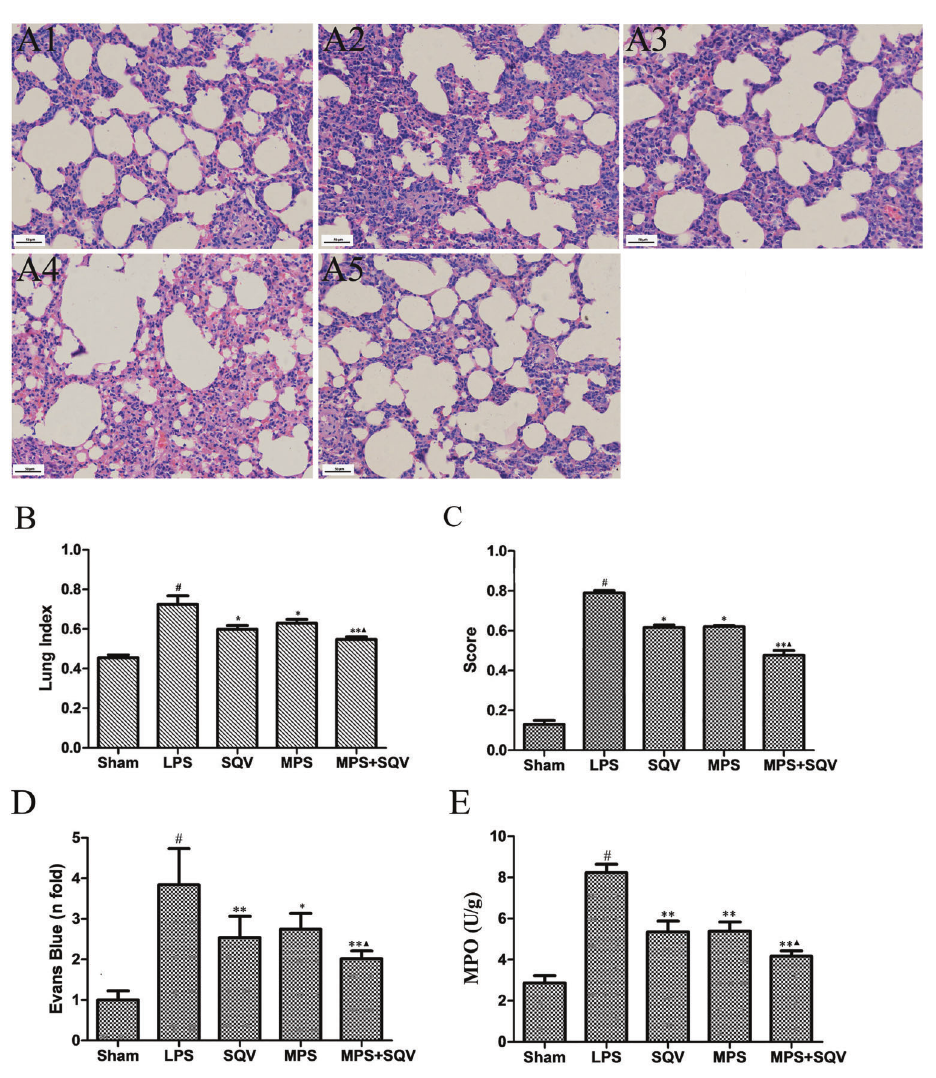
Figure 5. In fl uence of saquinavir (SQV) plus methylprednisolone (MPS) on histopathological change and lung index in acute lung injury (ALI) model. Typical light minute appearance of hematoxylin and eosin staining for sham ( A1 ), lipopolysaccharide (LPS) ( A2 ), SQV ( A3 ), MPS ( A4 ), and MPS plus SQV ( A5 ). Scale bar = 50 m m. B and C : Effects of SQV on the lung index and scores of histopathological change in the two-hit ALI rats. D : Effects of SQV on pulmonary capillary permeability. E : Effects of SQV on MPO activity in lung tissue. Data are reported as means ± SD. # P o 0.01 vs the sham group; *P o 0.05, **P o 0.01 vs the LPS-treated rats. m P o 0.05 vs the MPS group. Histopathological scores between groups were evaluated using the Wilcoxon rank-sum test. Quantitative data was analyzed by ANOVA with Dunnett ’ s